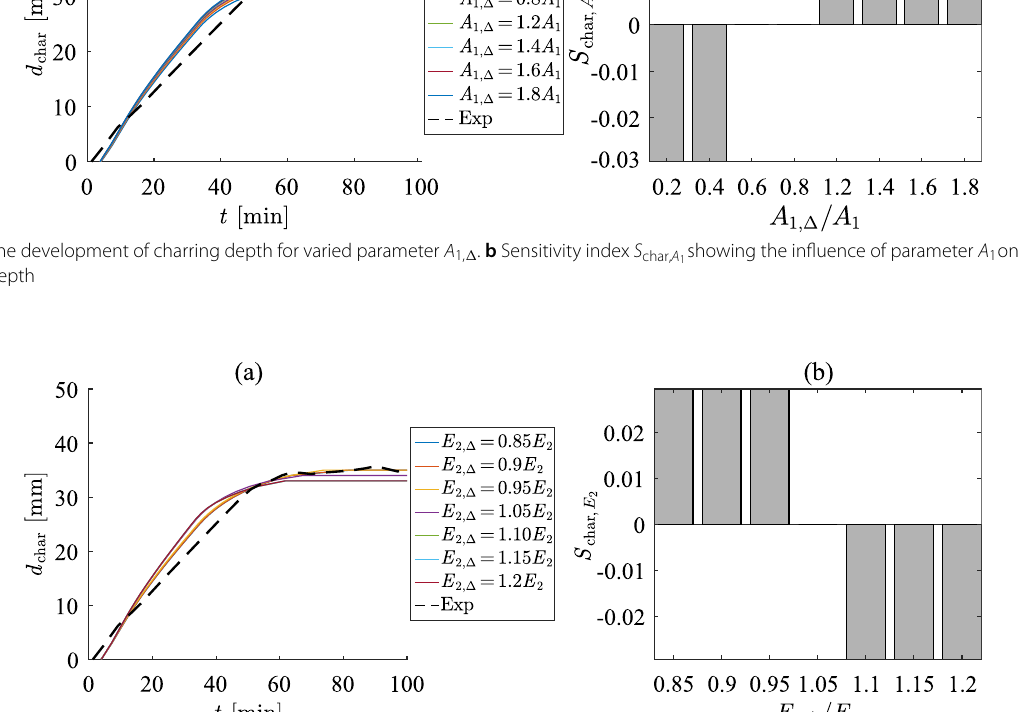
showing the influence of parameter E 2 on the final 2